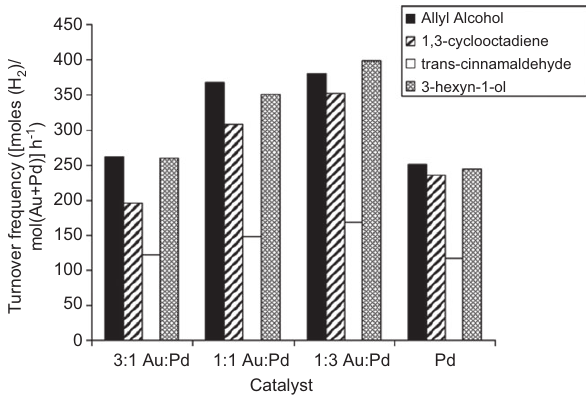
Figure 5 Comparison of the TOFs for the hydrogenation of allyl alcohol, 1,3-cyclooctadiene, trans-cinnamaldehyde, and 3-hexyn- 1-ol by Pd-Au NPs in [C